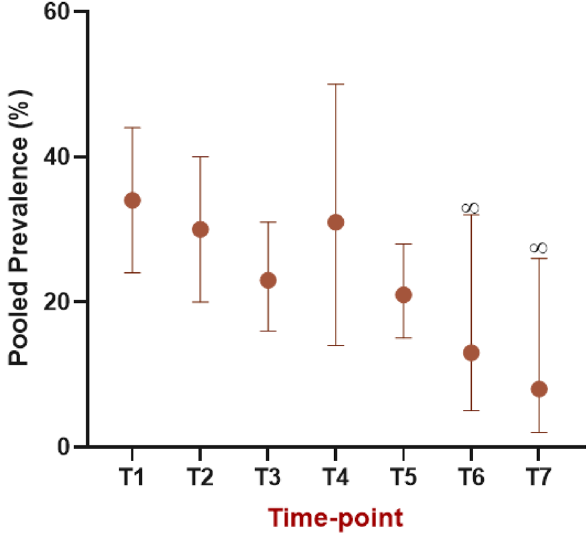
Figure 6. Prevalence reported for cognitive impairment, via neuropsychological test methods, across the time- points included in the review. Data represent pooled prevalence estimates derived from meta-analysis, with 95% CIs. ∞—values are not pooled figures but represent individual values from one